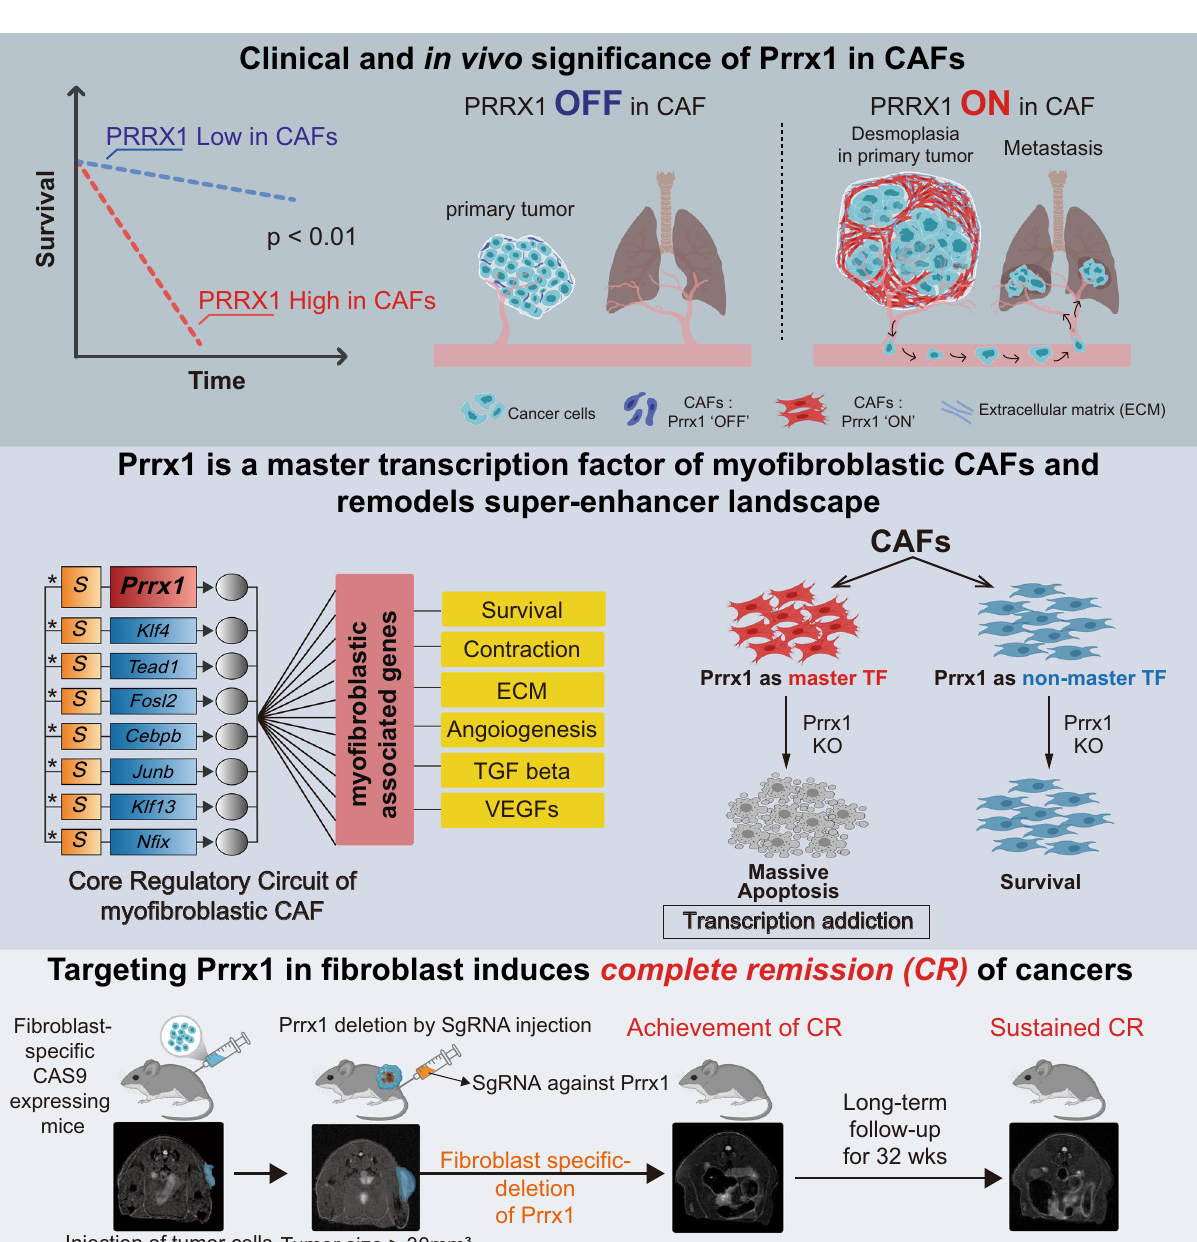
Fig. 10 Summary of the overall fi ndings. PRRX1 is the master transcription factor (mTF) that determines the lineage of highly pro-tumorigenic cancer- associated fi broblasts (CAFs) with a myo fi broblastic phenotype through remodeling a super-enhancer landscape. Targeting the mTF, PRRX1 belonging to the CAF subgroup with a myo fi broblastic phenotype may be a promising cancer treatment (Supplementary Fig. 20H), we designed seven unique sgRNAs targeting the gene Prrx1 . After determining the most potent sgRNA in an in vitro assay in the mouse- derived wound-healing fi broblast cells (Supplementary Fig. 20F), titering of viral particles was done with qPCR and western blot analysis. Virus delivery into the skin . The formulation was subsequently administered to Cas9-expressing mice. Two-month-old mice were anesthetized using iso fl urane and set up in a biosafety cabinet. Mice were injected intradermally around the wound area with 100 μ L concentrated sgRNA once every 3 days from the wounding start. For effective delivery, the intraperitoneal injection (IP) was per- formed simultaneously. In our study, we observed no signi fi cant change in the gross measure of health in mice. Detection of nuclease-induced genomic mutations . Genomic DNA was extracted using DNeasy Blood and Tissue extraction kit (Qiagen) following the manufacturer ’ s instructions. The target locus was ampli fi ed by PCR using High